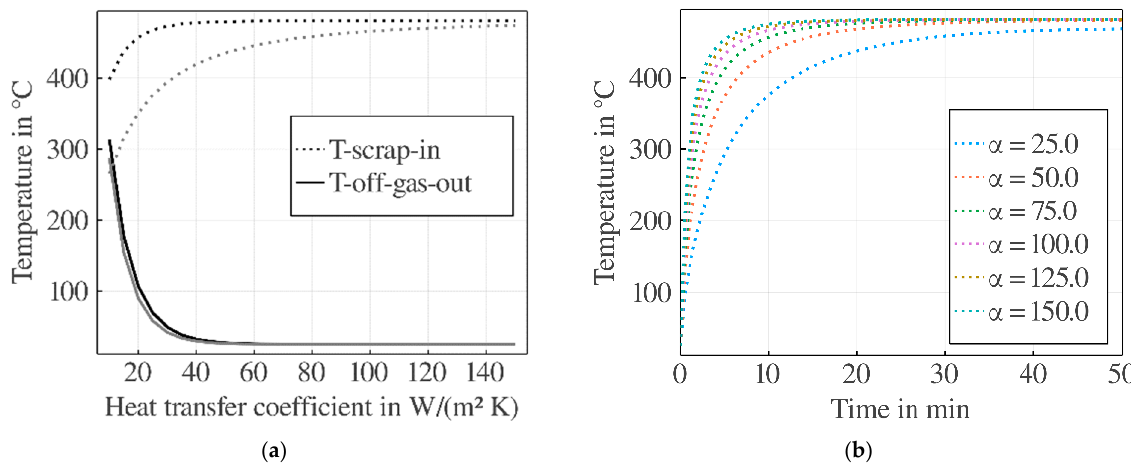
Figure 15. Scrap (S3) preheating and off-gas outlet temperature after 5 (gray lines) and 50 min (black lines) for different heat transfer coefficients a fs (= α ) ( a ); scrap (S3) preheating temperature development for different heat transfer coefficients a fs (= α ) ( b ).